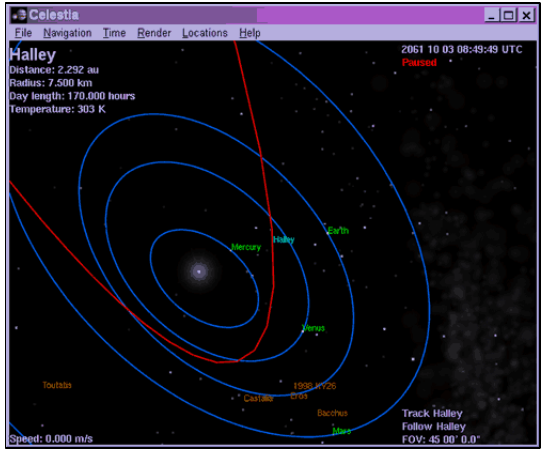
Fig. 11. Celestia Halley Comet 3D Simulation [17].